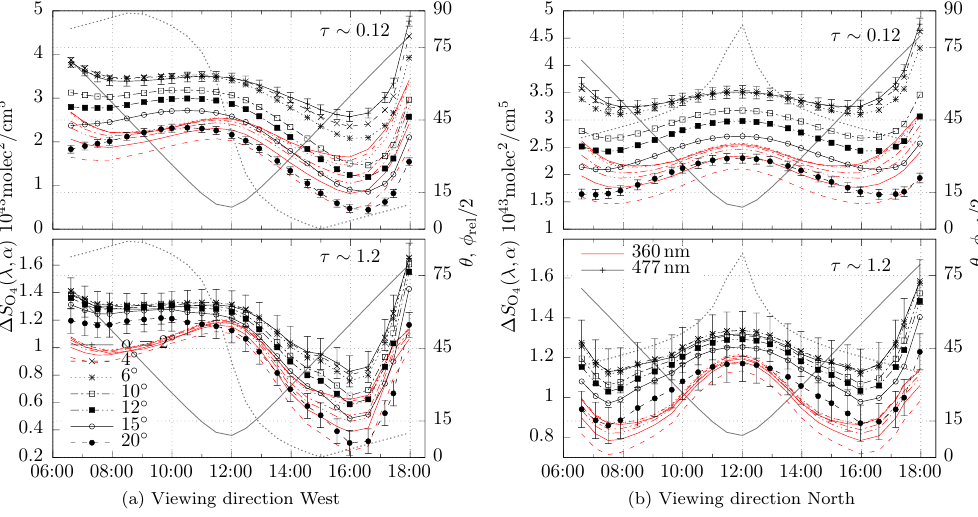
Fig. 2. Differential slant column densities of O 4 for the model experiment specified in Table 1 and a well-mixed ground layer of height H L =1.5km for viewing direction west (a) and north (b) . Top row with low aerosol load, and bottom row with high aerosol load. Layer parameters (see Fig. 1) are k L =0.05km − 1 , τ L =0.075, τ E =0.048 (top panels) and k L =0.5km − 1 , τ L =0.75, τ E =0.48 (bottom panels) at λ fm =477nm. The exponential part of the profile has a scale height ζ =1km. Solar zenith and relative solar azimuth angles θ and φ rel referring to Shanghai (31 ◦ 12 0 N, 121 ◦ 30 0 E) on 5 June 2010 are here and in following figures indicated by the solid and dashed line,